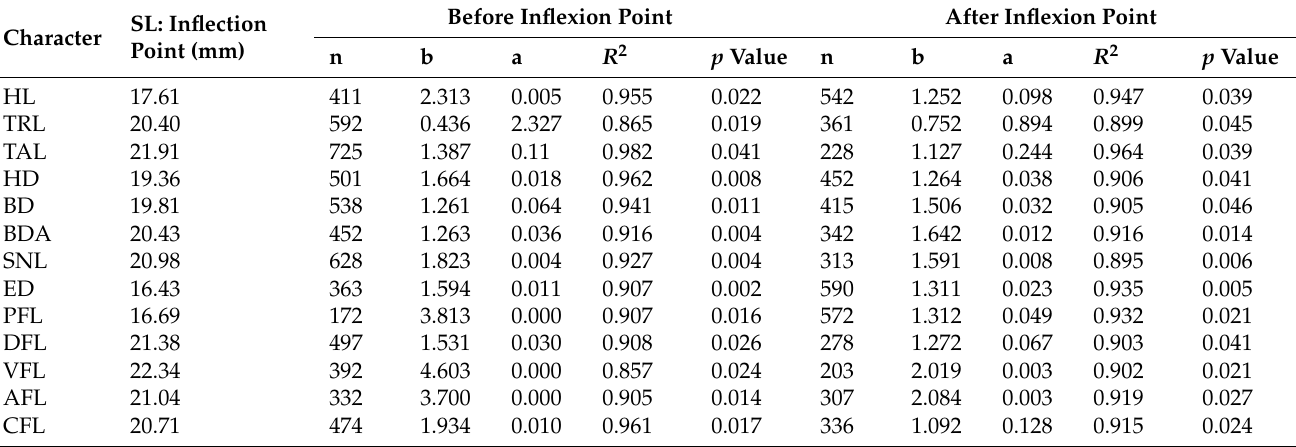
Table 1. Regression parameters for allometric growth of S. waltoni larvae.